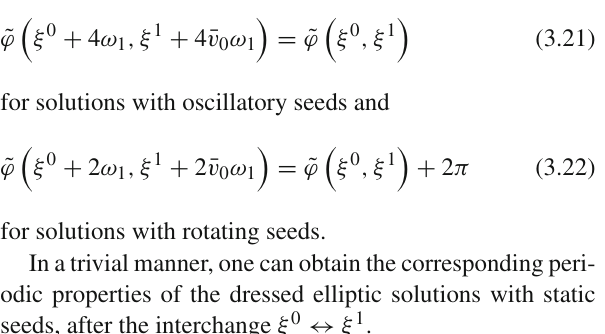
Fig. 5 The mean velocity as function of ˜ a for translationally invariant seeds (left) and static seeds (right) for various values of the energy constant E